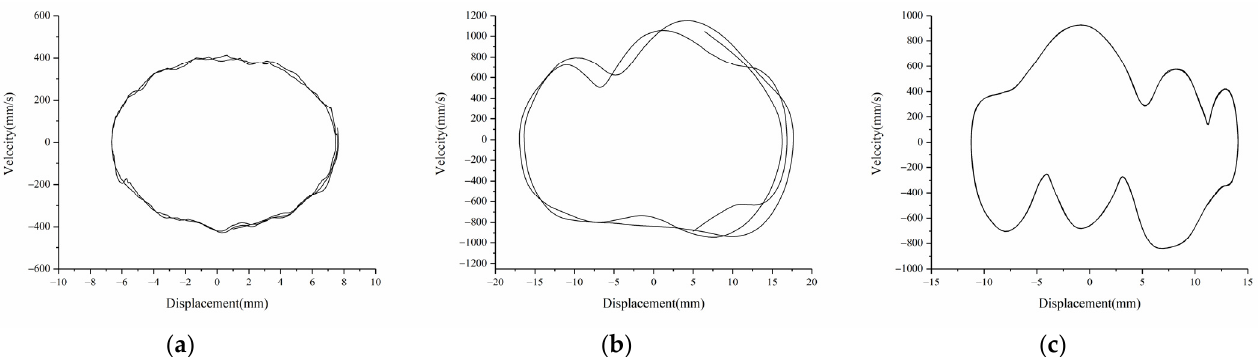
Figure 12. Experimental phase portrait of different magnetic distance: ( a ) d = 22 mm, d g = 8 mm; ( b ) d = 16 mm, d g = 6 mm; ( c ) d = 16 mm, d g = 8 mm.